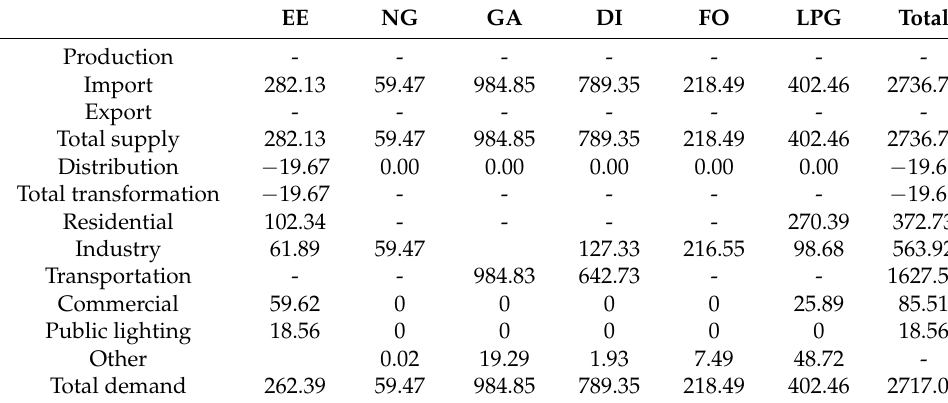
Table 12. Energy balance of the city of Cuenca canton (kBOE).